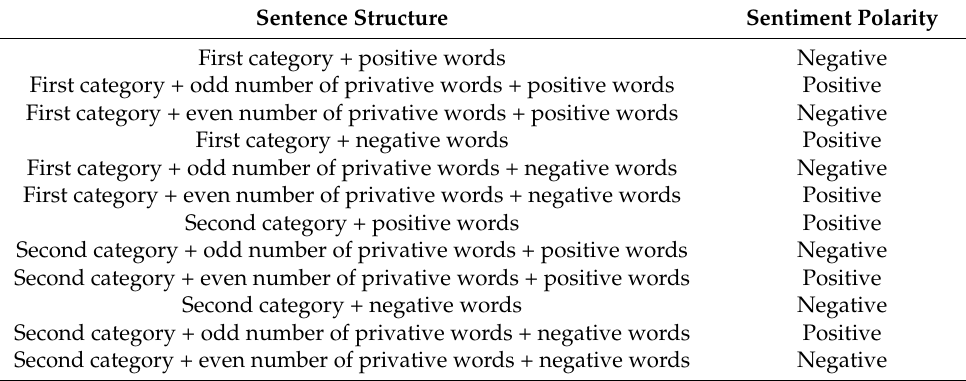
Table 3. The rules for determining the sentiment polarity of texts with adversative